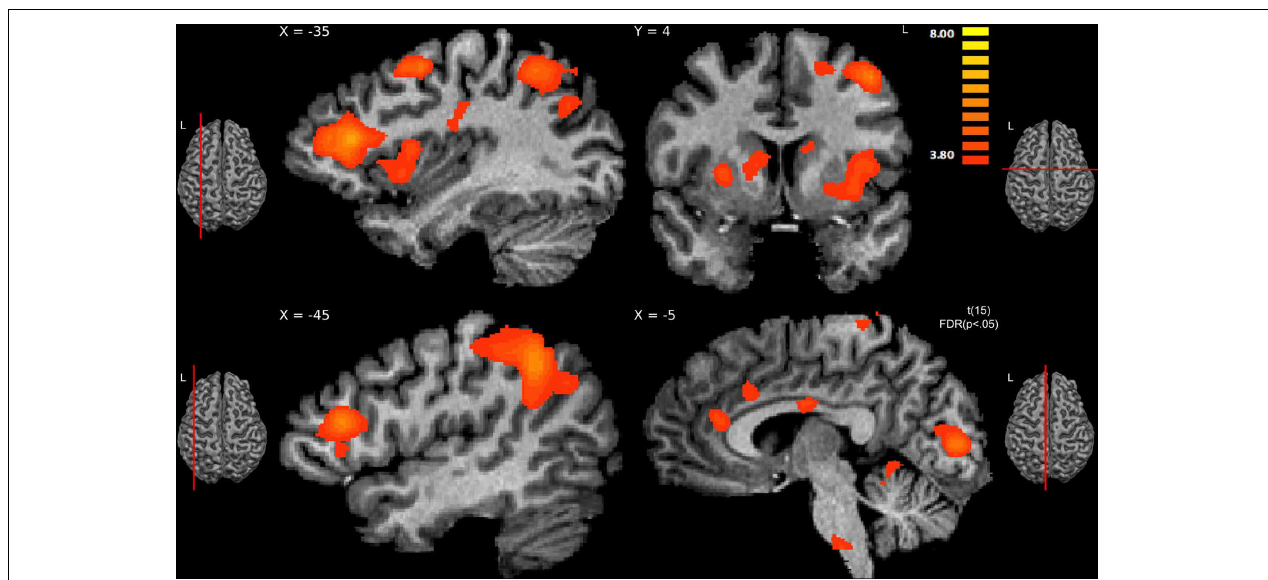
dorsal frontal cortex; slice x = − 45 shows activity in the inferior frontal gyrus; the other sagittal slice ( x = − 5) shows activity in the anterior cingulate cortex and brainstem. The coronal slice ( y = 4) shows activity in the right caudate and putamen, left caudate, left insula, and left dorsal frontal cortex.